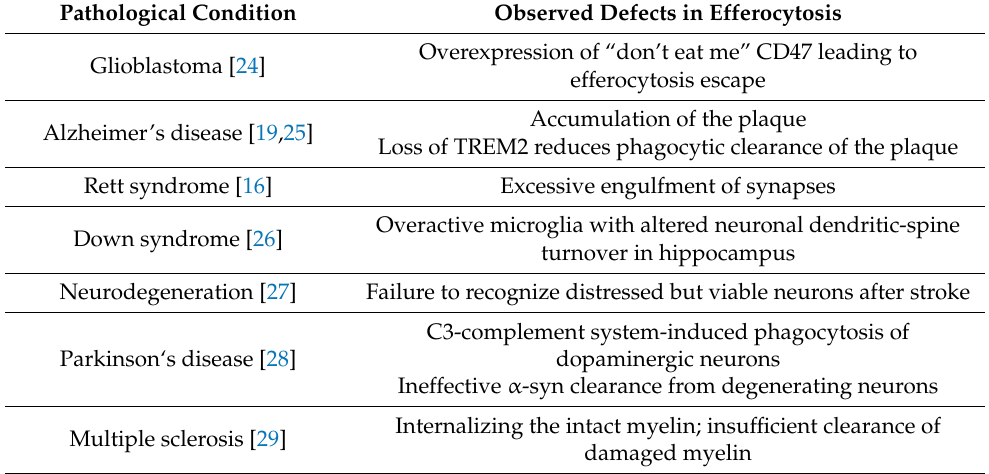
Table 1. Defective efferocytosis-based brain